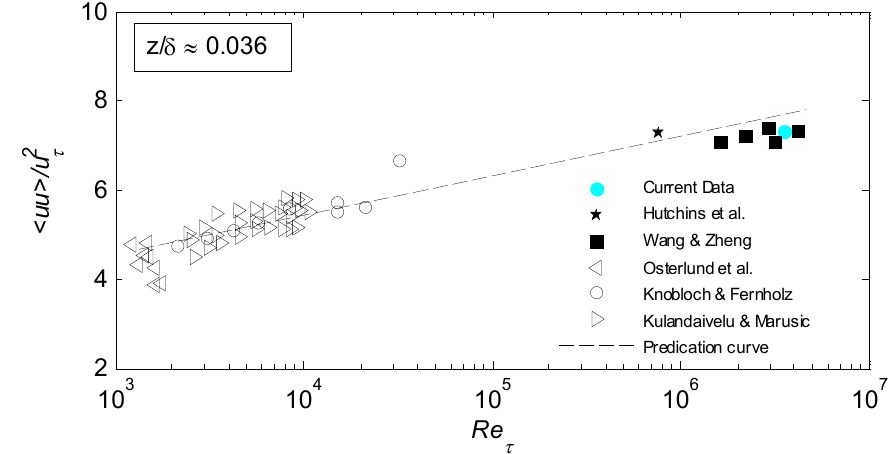
line), Re τ = 3.2 × 10 6 (black dash line), Re τ = 3.8 × 10 6 (black dotted line).